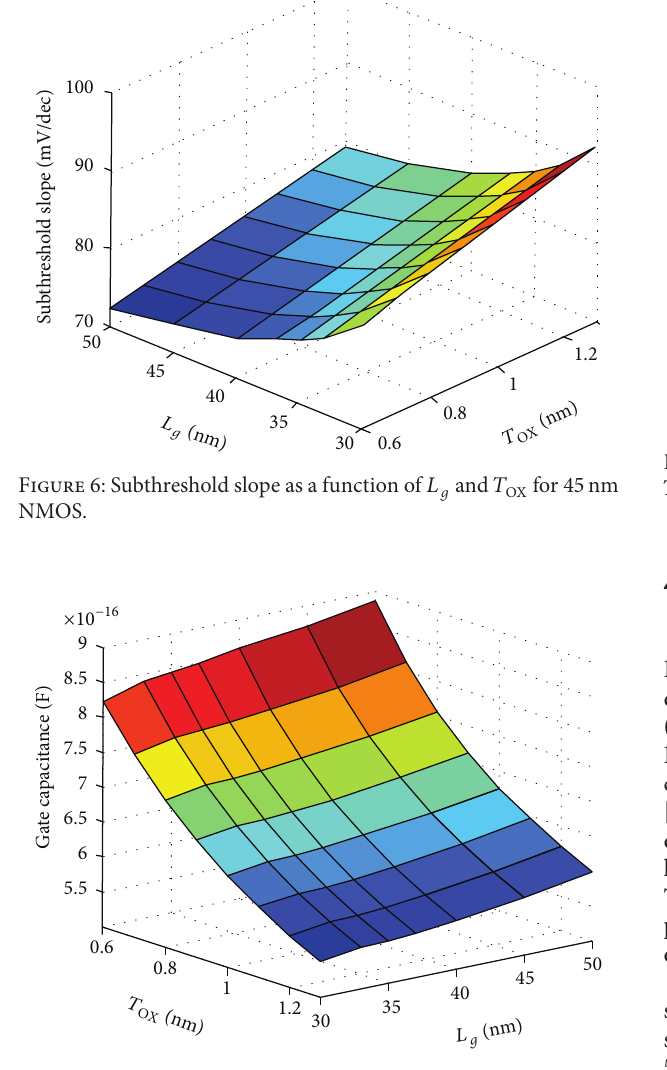
Figure 7: Gate capacitance as a function of 𝐿 𝑔 and 𝑇 OX for 45 nm NMOS.